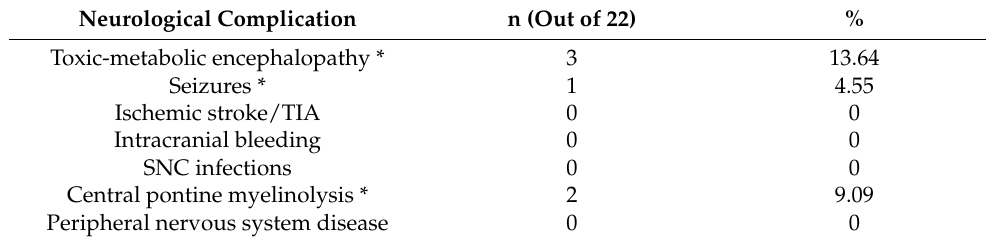
Table 2. Peri-operative acute neurological complications.